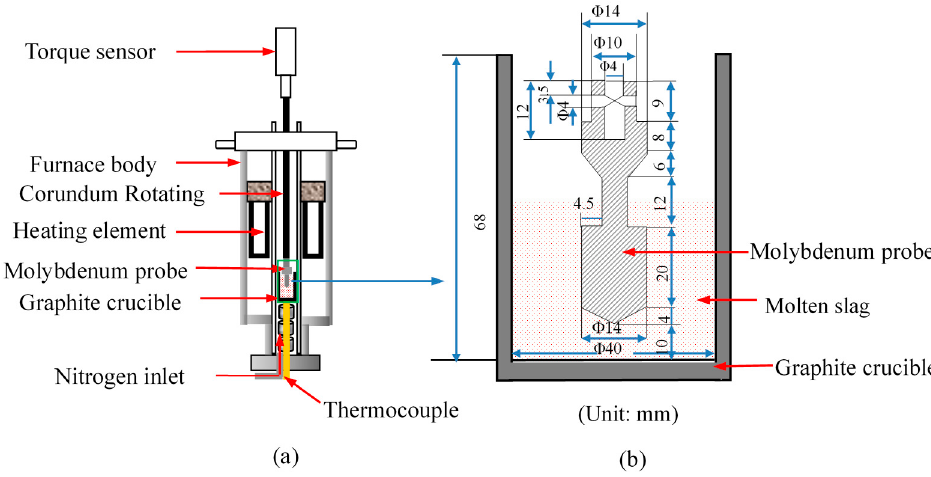
Figure 3. Experimental apparatus for slag viscosity measurement ( a ) and graphite crucible ( b ). In each run, the mixed sample of slag and UPC was placed in a graphite crucible.